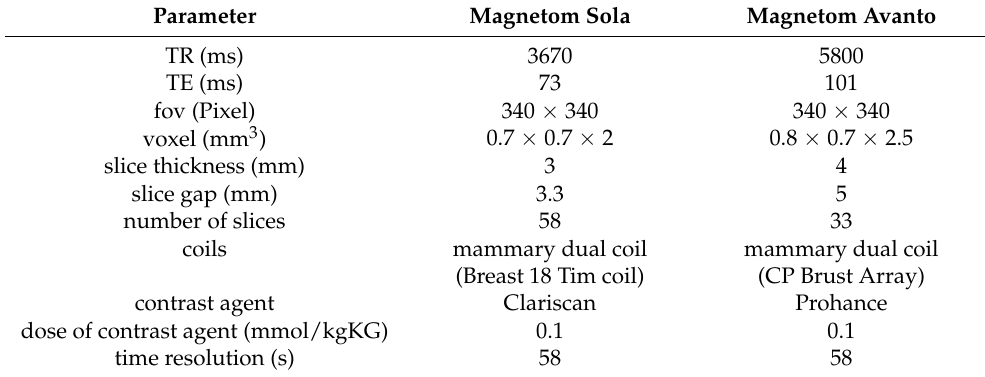
number of slices coils mammary dual coil mammary dual coil (Breast 18 Tim coil) (CP Brust Array) contrast agent Clariscan Prohance 0.1 0.1 time resolution (s) 58